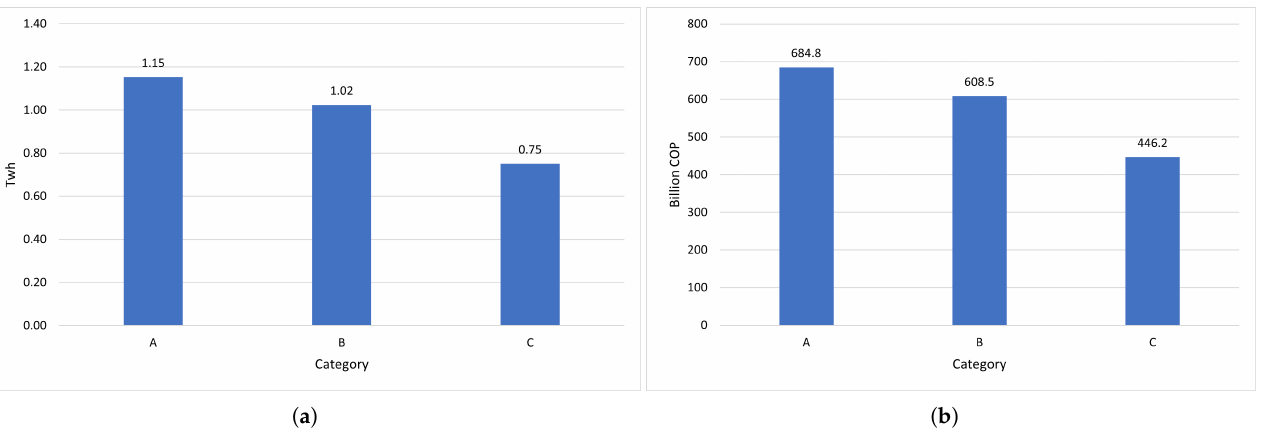
Figure 13. ( a ) Energy Savings and ( b ) Total Savings in Billions of